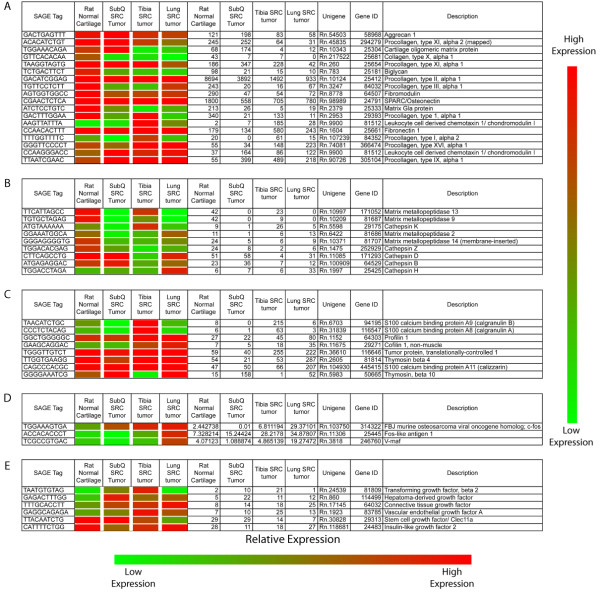
SAGE reveals gene expression differences between the SRC tumors and normal cartilage as well as gene expression differences between SRC tumors. (A) Expression of extracellular matrix genes. (B) Expression of extracellular matrix modifying proteases. (C) Expression of genes related to cell motility. (D) Expression of components of the AP-1 transcription factor complex. (E) Expression of growth factors. The Heat map represents relative gene expression. Actual expression values are listed to the right of the heat map.